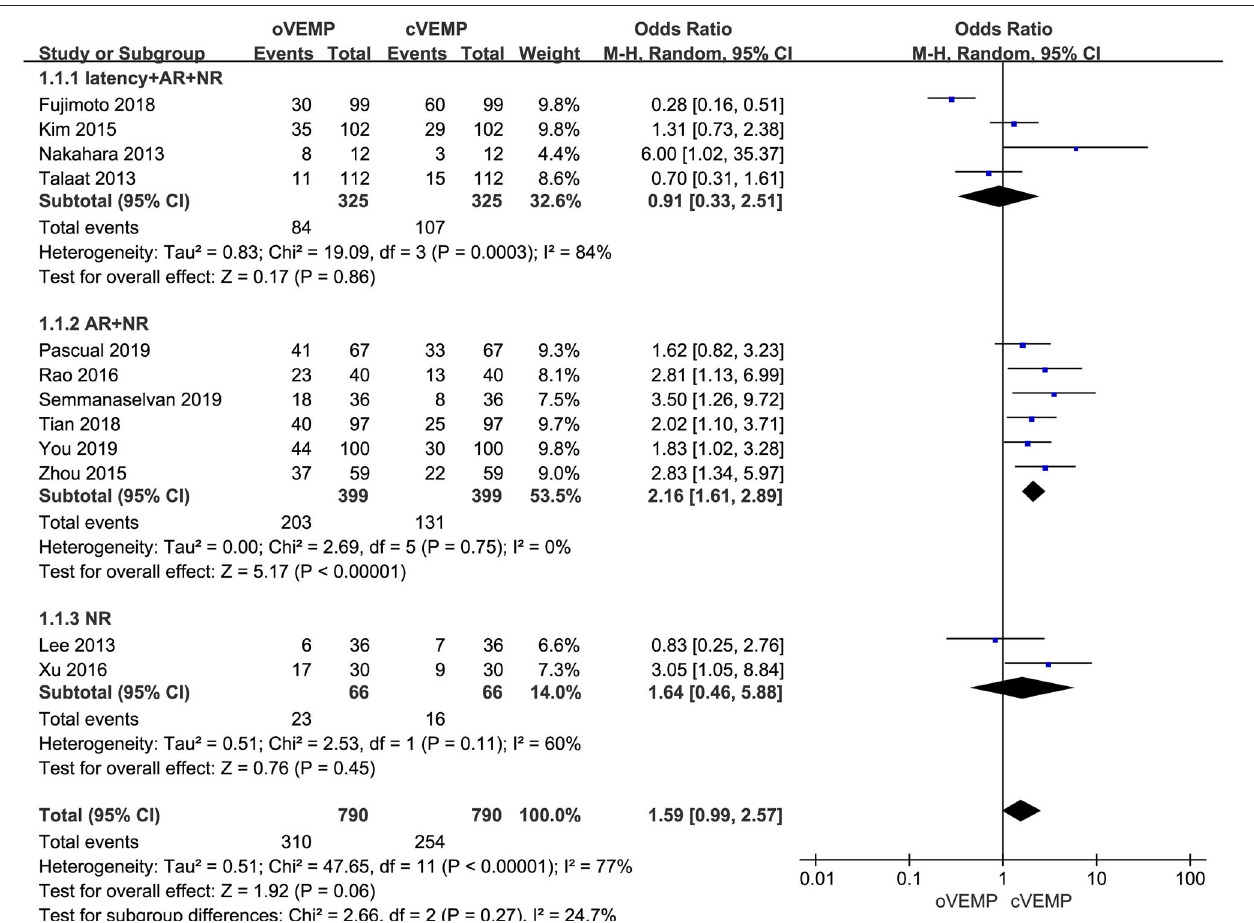
FIGURE 3 | Meta-analysis of abnormal rate of vestibular evoked myogenic potential (VEMP) in benign paroxysmal positional vertigo (BPPV) patients based on diagnostic criteria of abnormal VEMP.